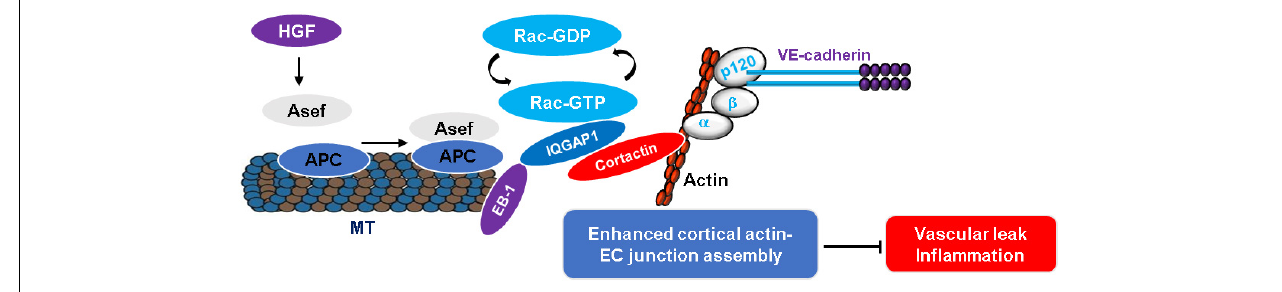
FIGURE 3 | MT-associated Rac regulation of endothelial barrier function. HGF stimulation of EC induces Asef, a Rac-specific GEF, activation which undergoes peripheral translocation by forming a complex with MT protein APC. In turn, Asef associates with IQGAP1 at the cell periphery and activates Rac, resulting in enhanced endothelial barrier integrity. The upregulated endothelial barrier function inhibits agonists-induced vascular leak and inflammation.